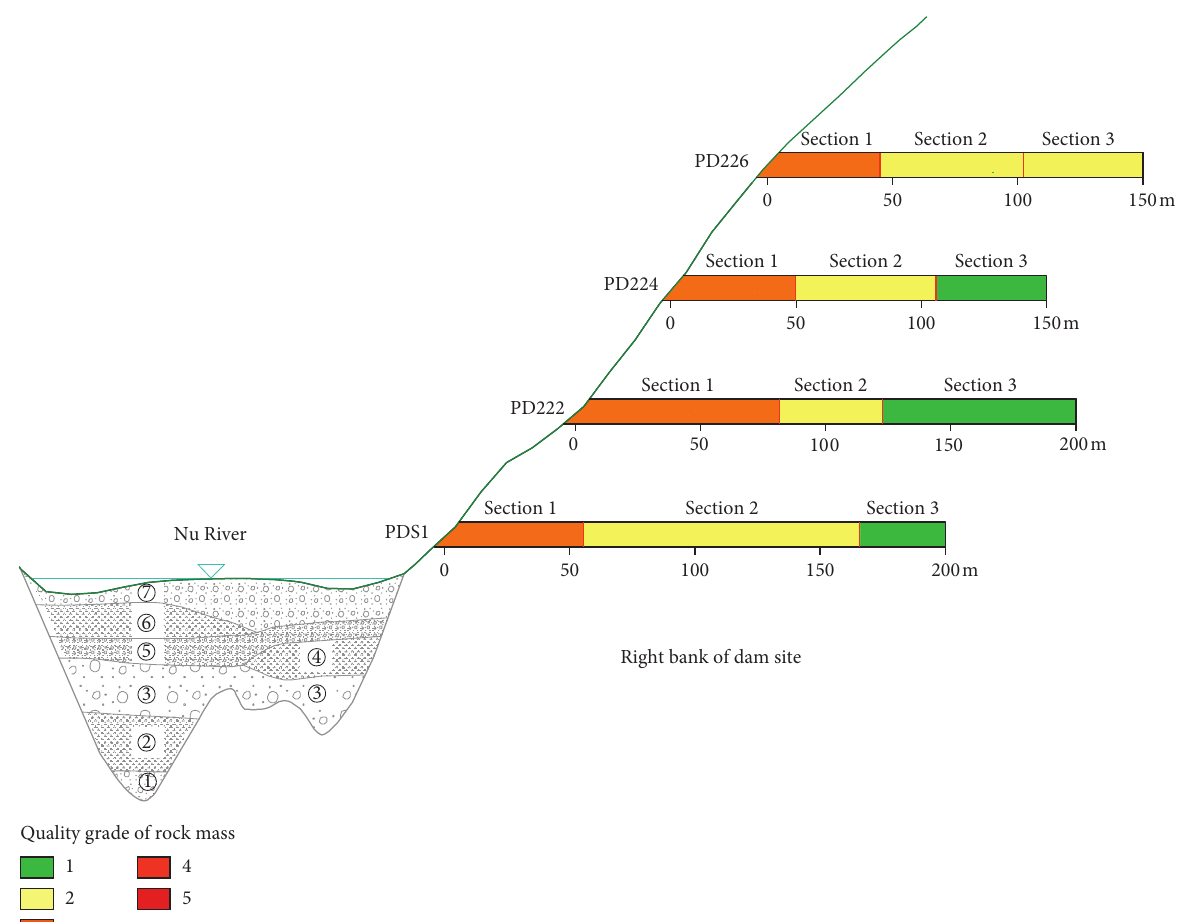
Figure 9: Spatial division of rock mass quality in the Songta dam